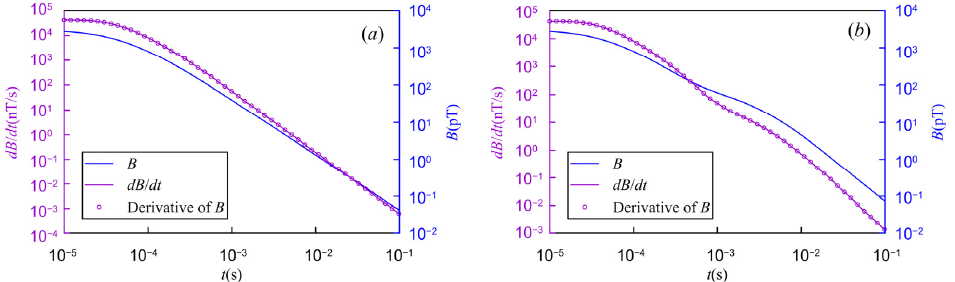
Figure 4. Comparison of SQUID TEM response and dB / dt response. ( a ) Uniform half-space, ( b ) H- type model.